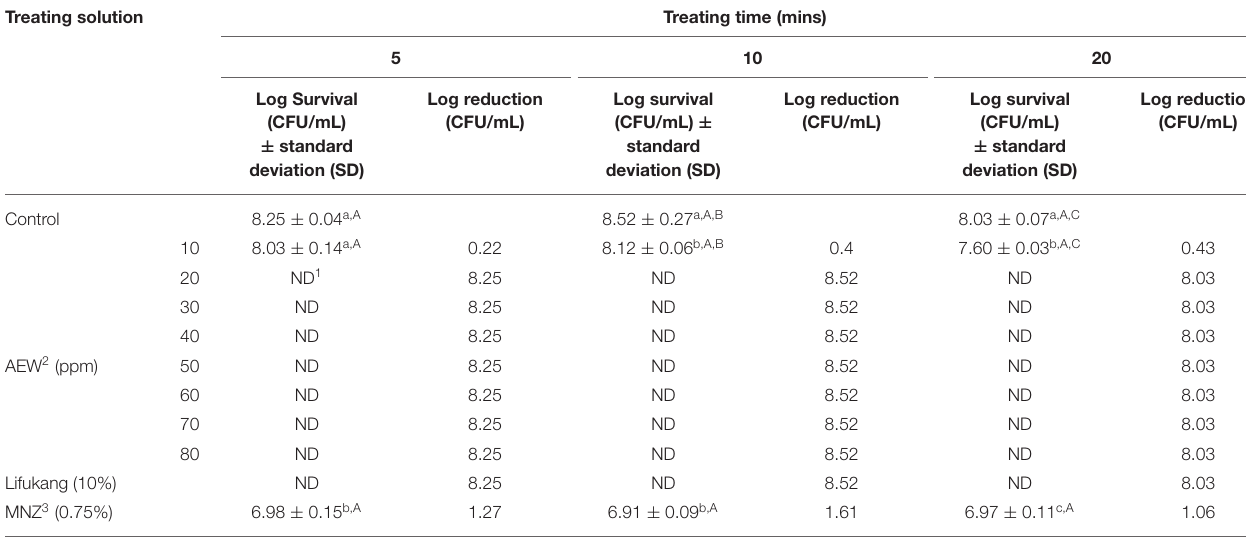
TABLE 2 | Treatment of AEW, Lifukang, and MNZ in GS. Treating solution